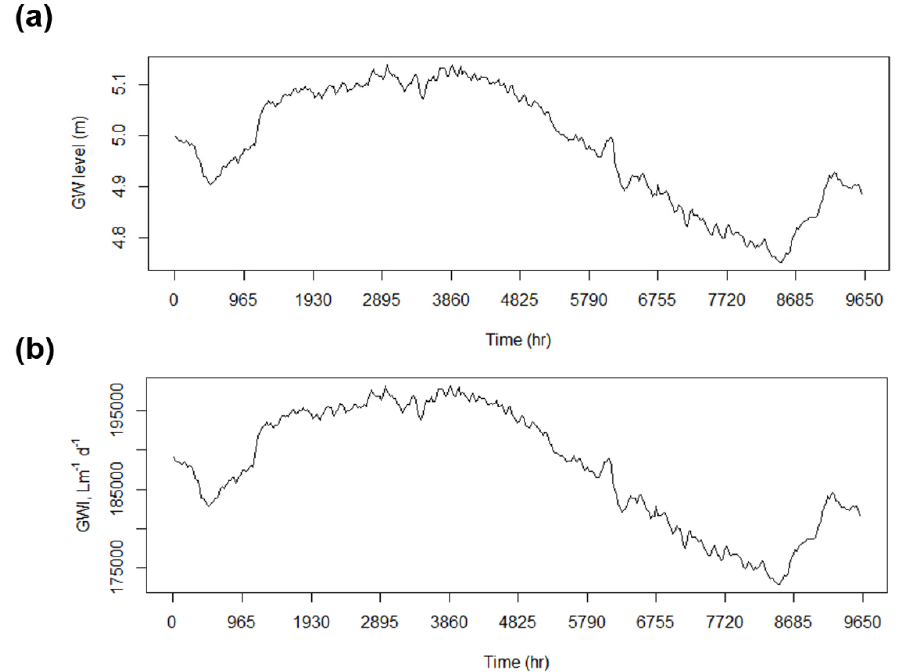
Figure 9. Groundwater variation at Pearl Harbor, HI case site from 1 September 2014 (t = 0 h) to 22 October 2015 (t = 10,000 h): ( a ) Groundwater level measurements referenced from mean sea-level; ( b )